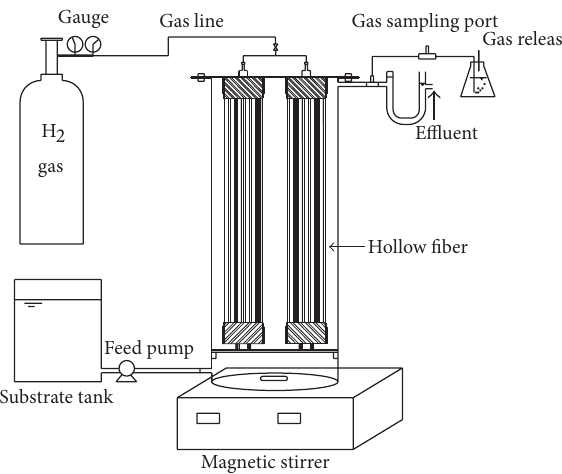
Figure 1: Schematic of the